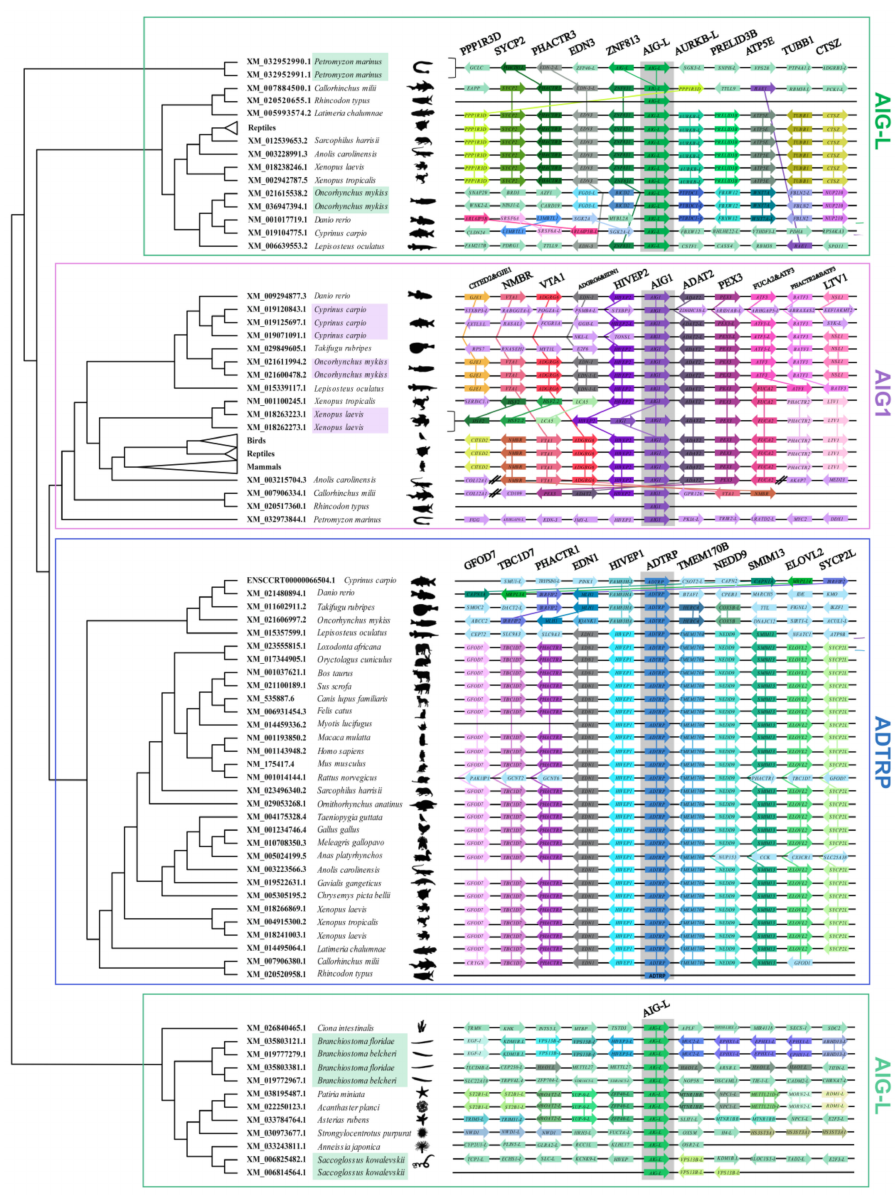
Figure 3. Syntenic analysis of AIG genes in representative species. The cladogram was adapted from Figure S2. The genes adjacent to AIGs (4–5 genes upstream/downstream) are shown as arrows with the arrowheads indicating the direction of orientation of the transcription of each